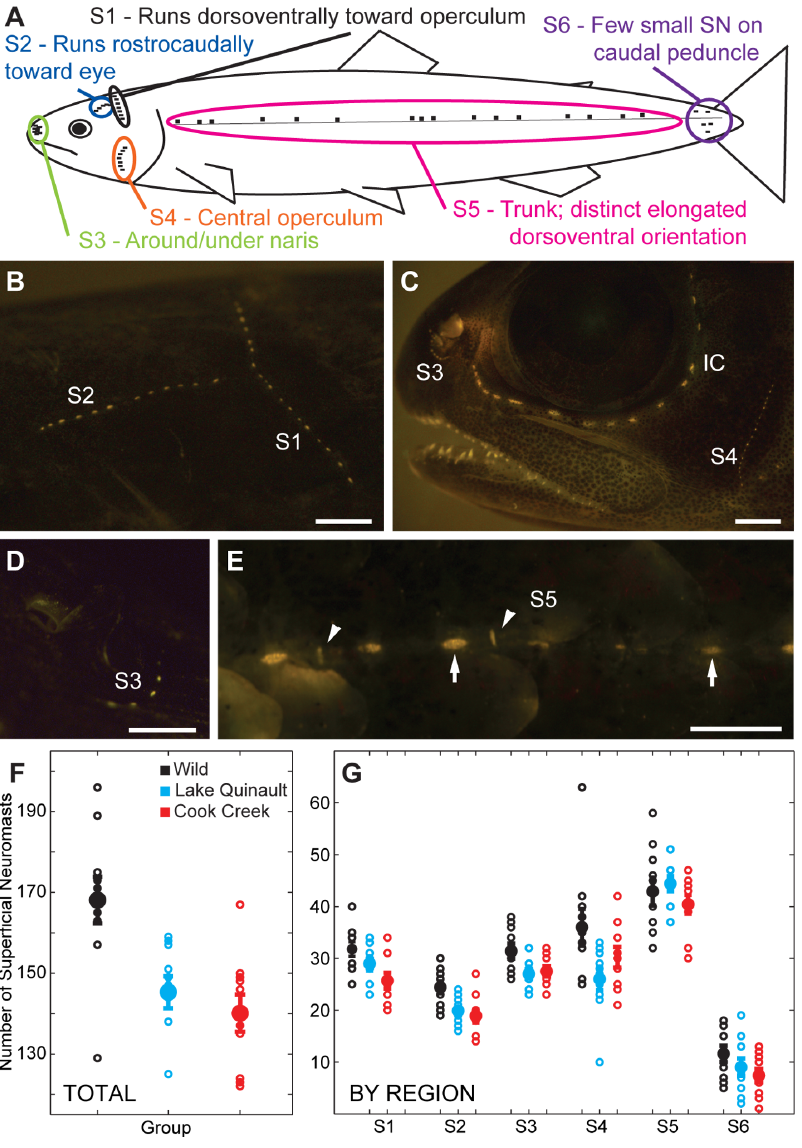
Figure 1. Differences in neuromast number across groups. (A) SN were clustered in one of six discrete ‘stitches’ or groupings, which we term for convenience in the present report S1–S6. Each of these stitches was treated as a region of interest for analysis of neuromast number. (B–E) Examples of DASPEI-labeled neuromasts from wild-origin juveniles (B–C) or Cook Creek hatchery fish (D–E). (B) Stitches S1–S2, showing how S2 intersects S1 near its midpoint, running anteroventrally toward the eye. Scale bar=1 mm. (C) Low-magnification image of the left side of the head, showing the stitch around the naris (S3) and the stitch over the operculum (S4). The infraorbital canal (IC) is also labeled in this image. This canal was not clearly visible in all specimens so neuromast number was not quantified. Scale bar=2 mm. (D) Stitch S3 (bordering a right-side naris) under higher magnification. Scale bar=1 mm. (E) SN from stitch S5 (arrowheads), which sits atop the trunk canal (arrows). Trunk canal neuromasts are elongated in the rostrocaudal direction, while adjacent SN are oriented dorsoventrally. Scale bar=1 mm. (F) Total neuromast number (summed across left and right sides) per fish (open circles) and per group (filled circles, mean 6 1 SEM, n =10 fish per group). There were significant differences in neuromast number between groups (one-way ANOVA F 1,2 =9.45, p =0.001). (G) SN number comparisons within each ROI using one-way ANOVA followed by Tukey’s post-hoc analysis. Individual and group data are plotted across ROIs. Statistical tests are summarized are in Table 1.